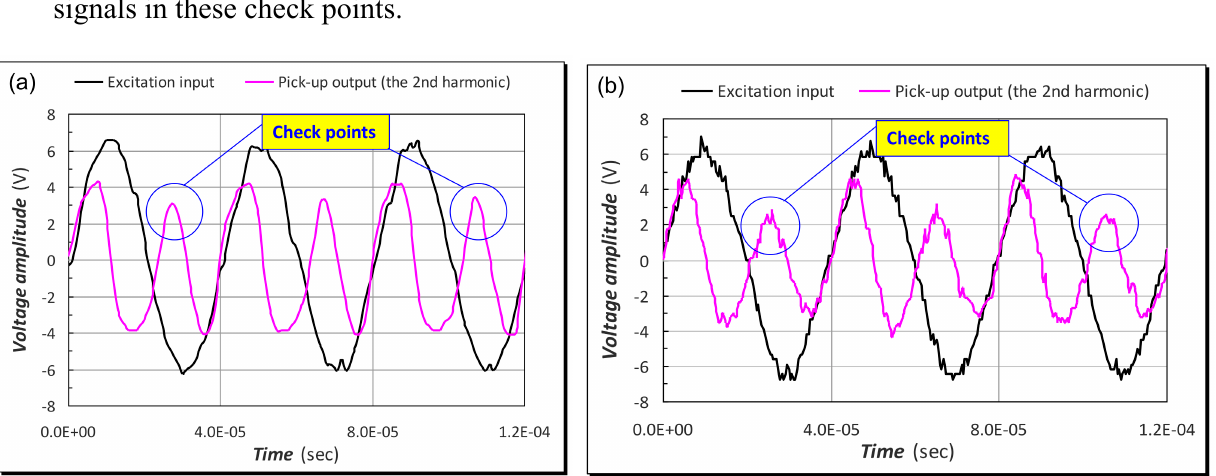
Figure 6. Comparison of the second harmonic waves measured by ( a ) the “flip chip” fluxgate and ( b ) the wire-wound fluxgate under dc earth fields without magnetic